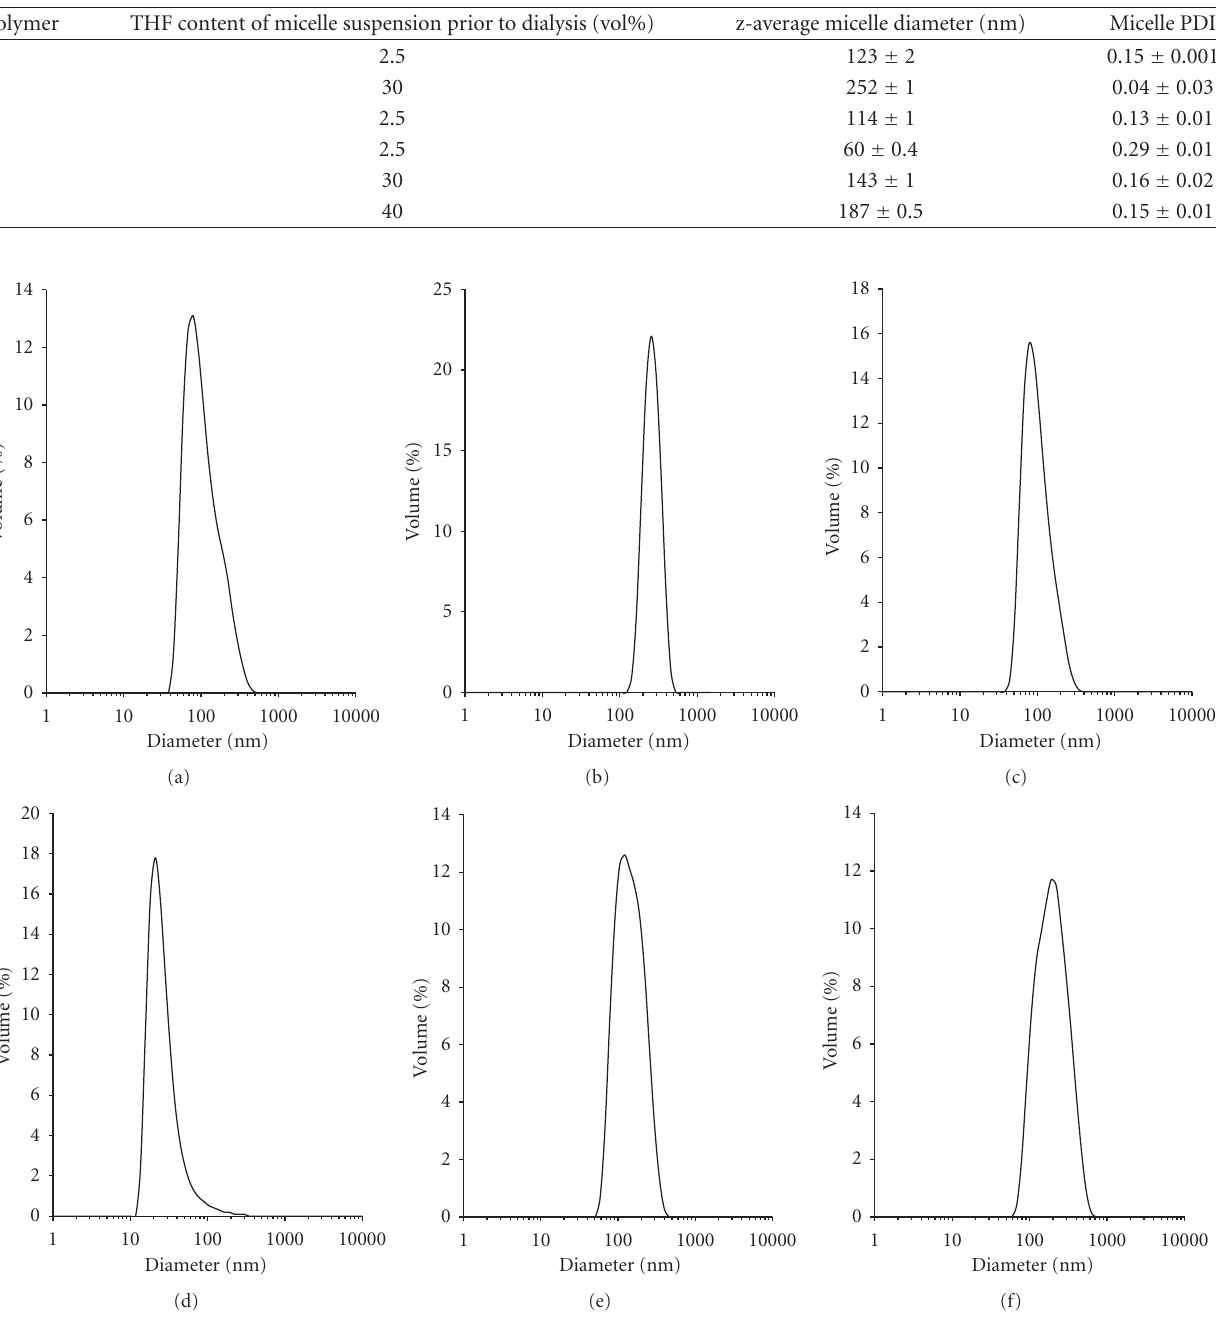
Table 2: Characterization of micelles formed by copolymers 7–9 by DLS. z-average micelle diameters represent the means of the measurement data for 3 di ff erent batches of micelles.